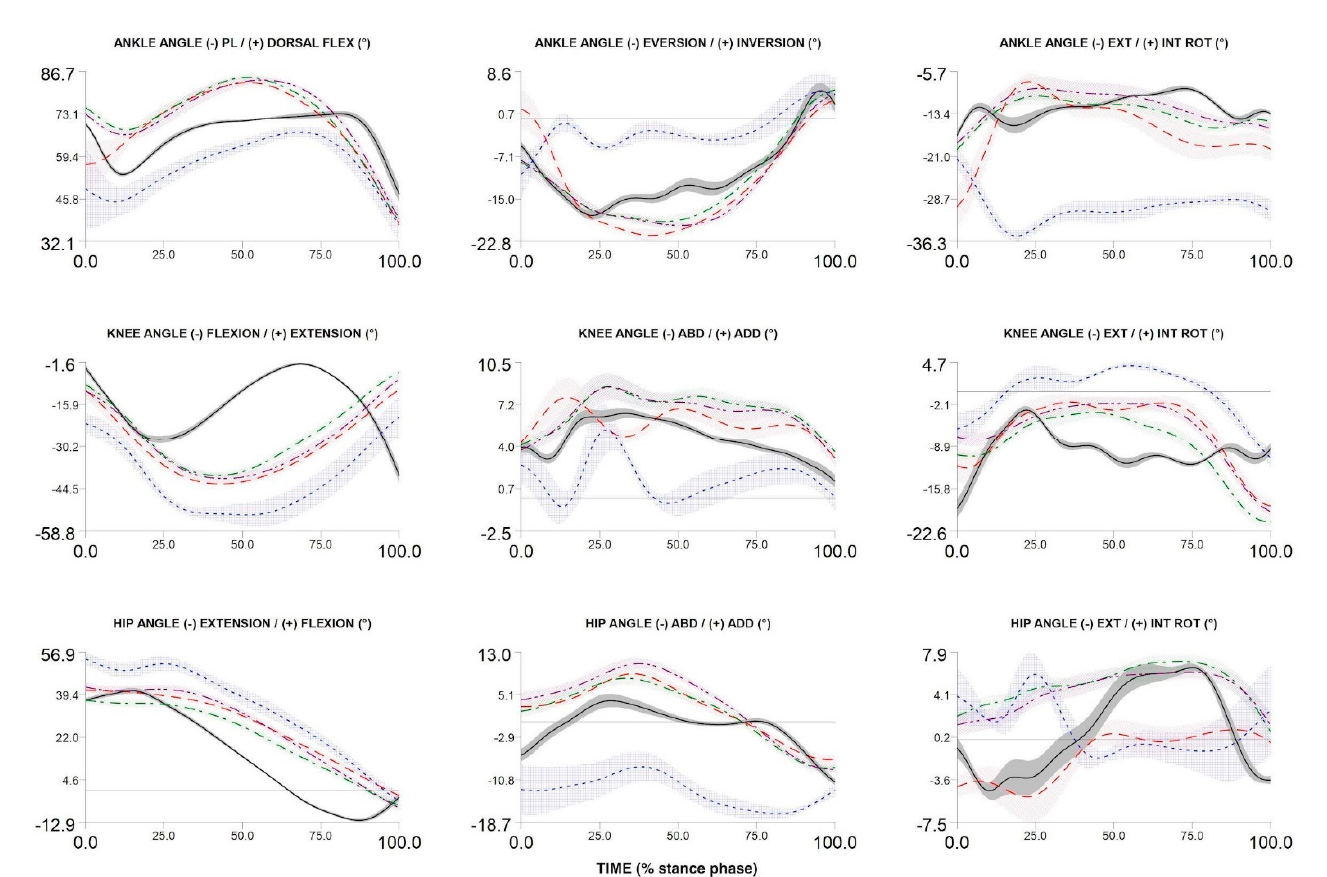
Figure 4. Three-dimensional ankle, knee and hip angles during stance phase of walking, over-ground running, treadmill running (3.0 m / s and 75% of maximum VO 2 max test speed) and cutting maneuver in one participant. Over-ground running—red dash line; walking—black solid line; cutting maneuver—blue dot line; TR3—green dash dot line; TRA—purple dash dot dot line.